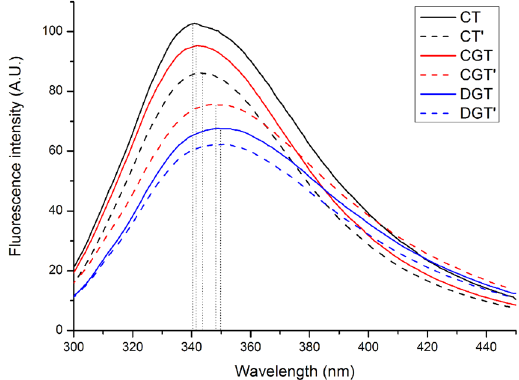
Figure 6. Fluorescence spectra of TRAIL IBs solubilized in denaturing solution. The emission spectra were recorded for IBs produced by wt (black lines), GroEL/ES + (red lines) and GroEL/ES − (blue lines). Spectra of IBs before (continuous) and after (dashed) in vivo refolding are shown. The maximum wavelength of each spectrum is shown as a dotted